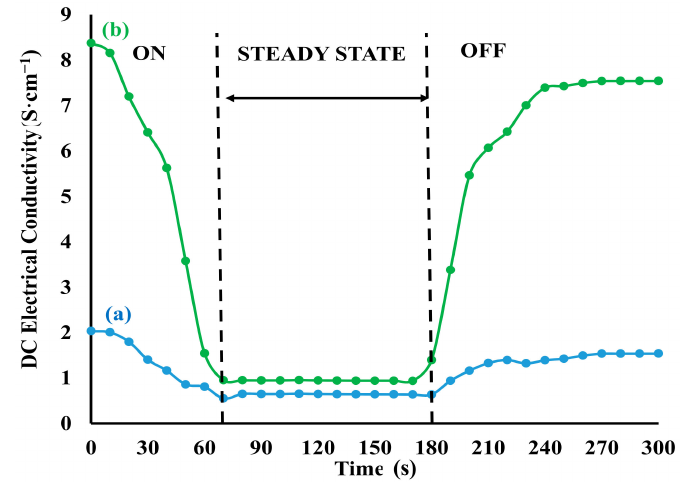
Figure 6. E ff ect on the DC electrical conductivity of ( a ) PPy and ( b ) PPy / MoS 2 nanocomposites upon exposure to (1000 ppm) ammonia vapors followed by exposure to ambient air with respect to